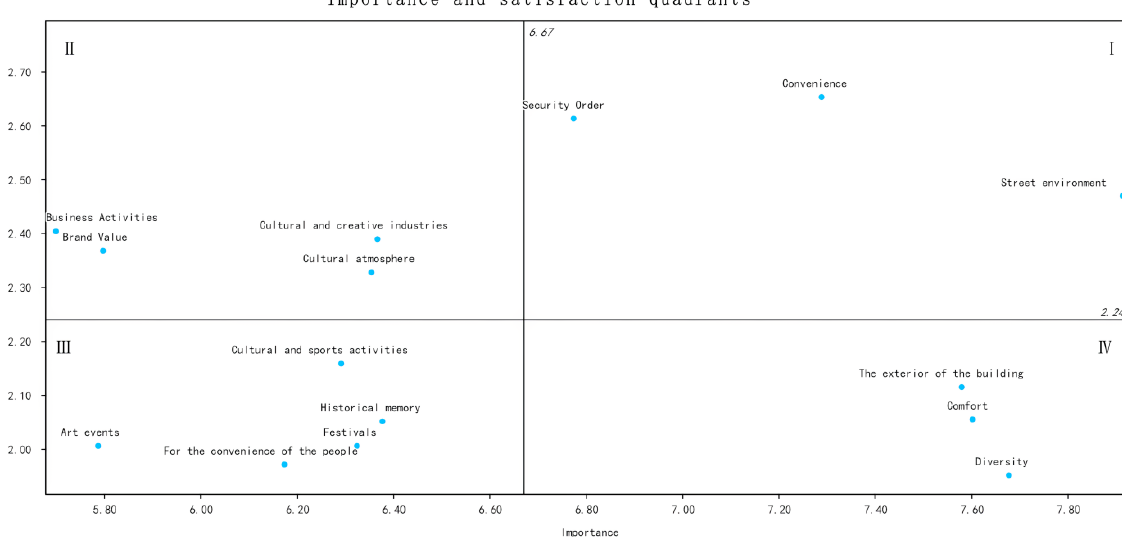
Figure 11. The IPA quadrant of commercial space in Nonglin Street. (I,II,III,IV stands for quadrant